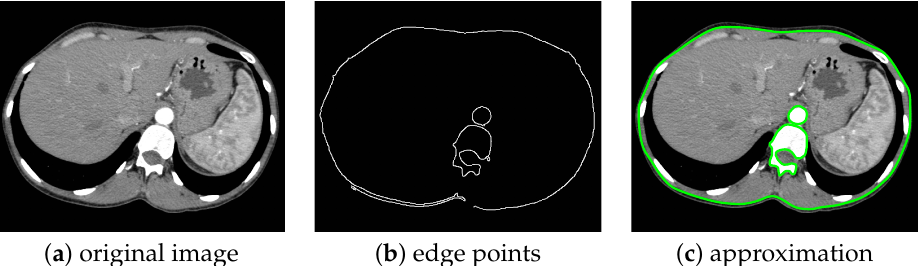
Figure 12. Recognition and approximation of different profiles in a CT slice. The original X-ray CT axial image ( a ) is processed and three sets of edge points are selected ( b ), corresponding to the body profile, the lumbar vertebra and the aorta; the three approximations obtained are then superimposed in ( c ). Note the presence of outliers in ( b